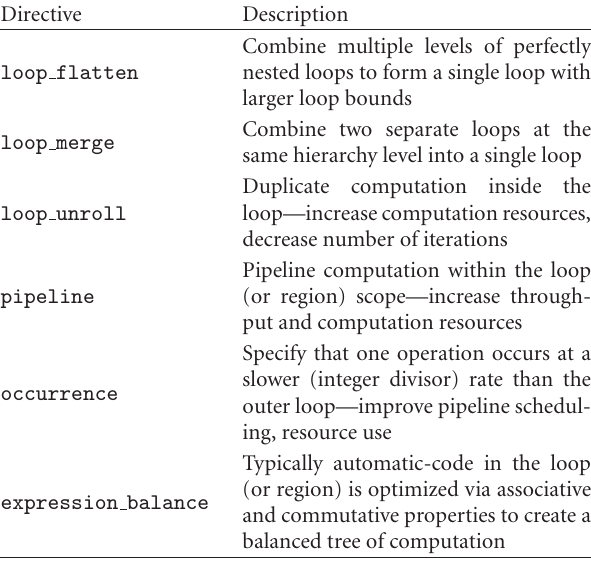
Table 1: Communication interface directives.